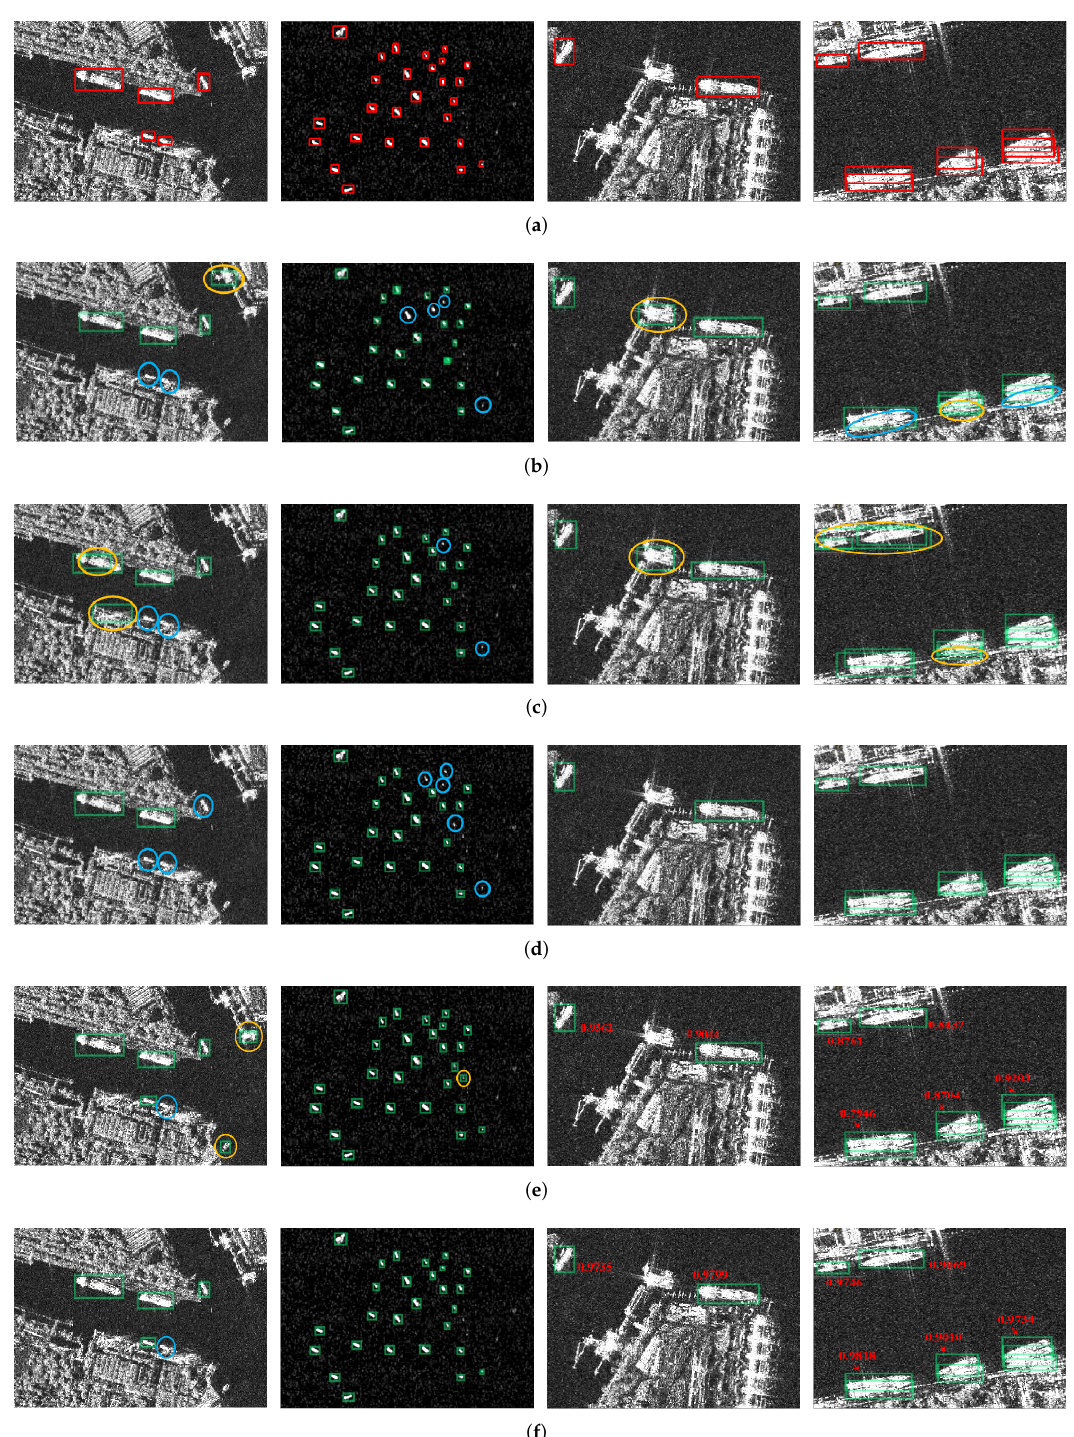
Figure 18. Comparison results of different methods on the SSDD dataset. The spring-green rectangles are the detection results. The blue and orange circles represent the missing ships and false alarms, re- spectively. The red value reflects the IoU between the predicted bounding box and the corresponding ground truth. ( a ) Ground truth. ( b ) Results of RetinaNet. ( c ) Results of Faster R-CNN. ( d ) Results of Cascade R-CNN. ( e ) Results of CenterNet-SSE. ( f ) Results of our